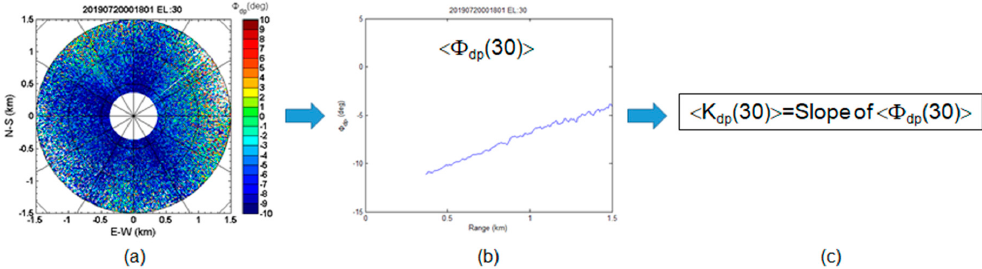
Figure 6. An example of mean K dp (<K dp >) retrieval from Φ dp scan. ( a ) Φ dp scan, ( b ) averaged Φ dp (< Φ dp >) , ( c ) mean K dp (<K dp >).